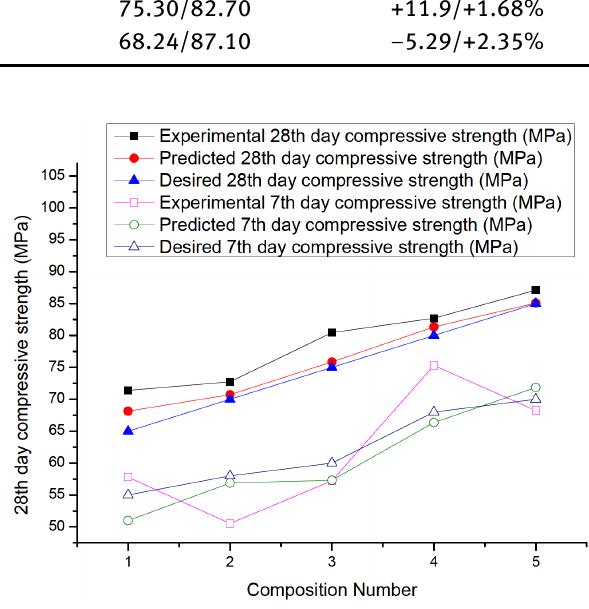
Figure 2: Comparison of the desired, predicted, and experimental